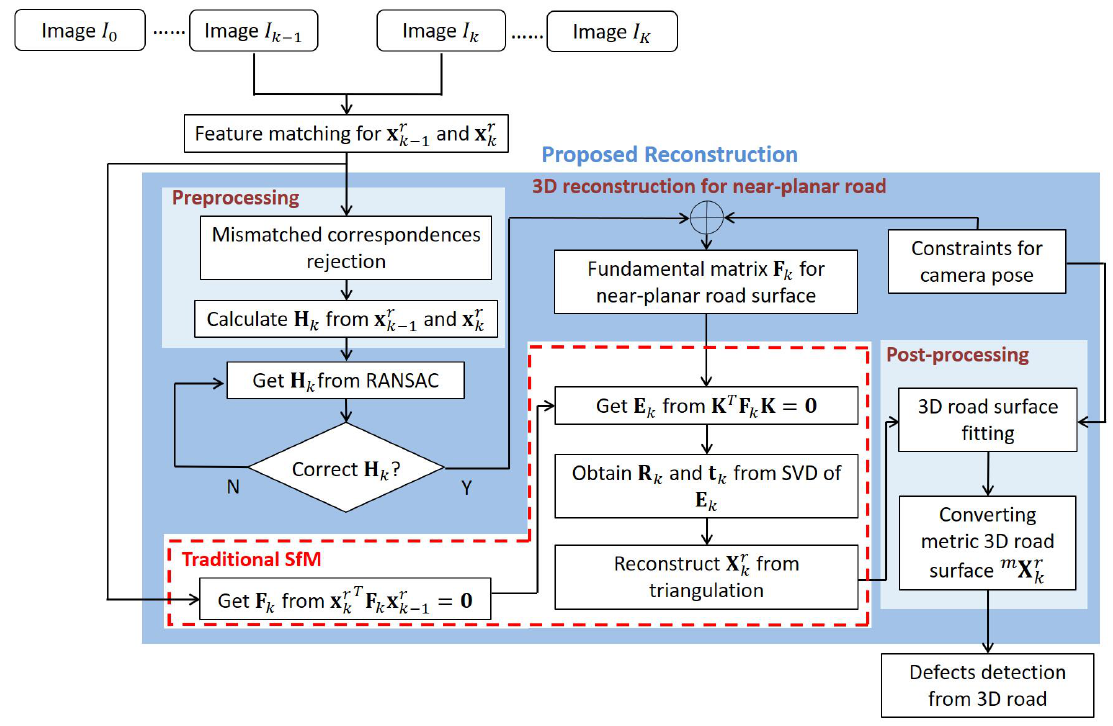
Figure 4. Proposed degenerate near-planar surface reconstruction technique for road defects